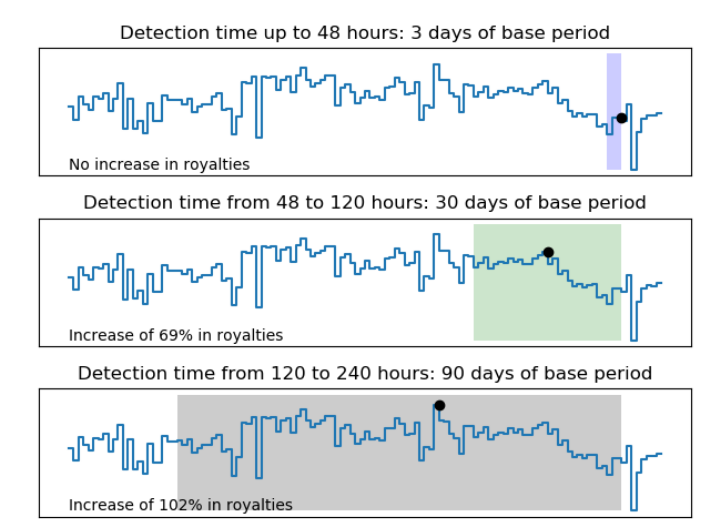
Figure 7. Three scenarios for the calculation of the royalty-bearings. The black point is the maximum daily mean of production in each hatched